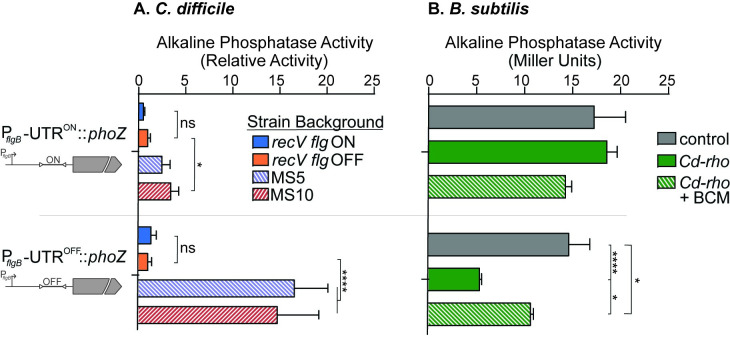
C. difficile Rho directly inhibits flagellar gene expression in flg OFF orientation.(A) Alkaline phosphatase (phoZ) reporter fusions to the flgB operon regulatory region, with the flagellar switch in either the ON or OFF orientation, were introduced into the recV flg ON (RT1702), recV flg OFF (RT1693), MS5 and MS10 strains. Alkaline phosphatase activity was normalized to the recV flg OFF values. The means and standard deviation of 5 biological replicates are shown. ****p<0.0001 by two-way ANOVA and Tukey’s post-test. (B) The C. difficile rho gene was introduced into Bacillus subtilis bearing the phoZ fusions to the flgB regulatory region with the flagellar switch in either the ON or OFF orientation. C. difficile rho (Cd-rho) was introduced, and alkaline phosphatase activity was assayed. Control–B. subtilis reporter without Cd-rho; BCM–bicyclomycin, 50 μg/mL. The means and standard deviation of three biological replicates are shown. ****p<0.0001, *p<0.05 by two-way ANOVA with Sidak’s post-test comparing strains with the same reporter construct.